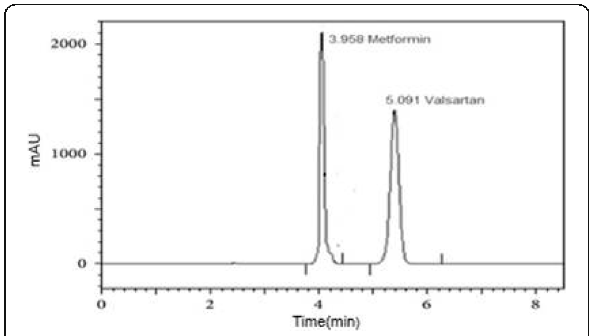
Fig. 3 Typical chromatogram of valsartan and metformin was obtained by injecting 20 μ L of each drug solution with flow rate 1 mL per minute performed with UV detector at 238 nm.